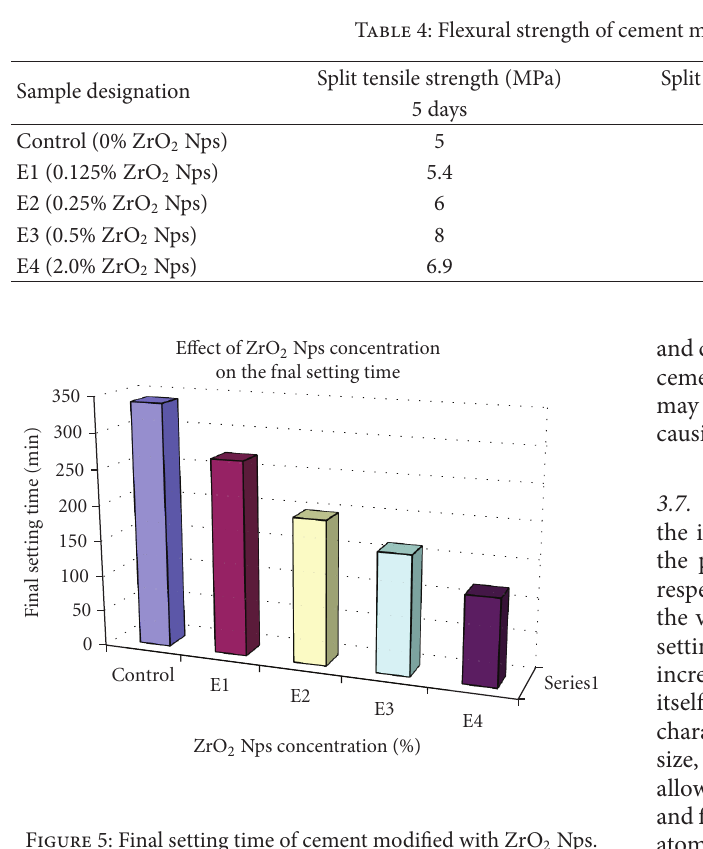
F 5: Final setting time of cement modi�ed with ZrO